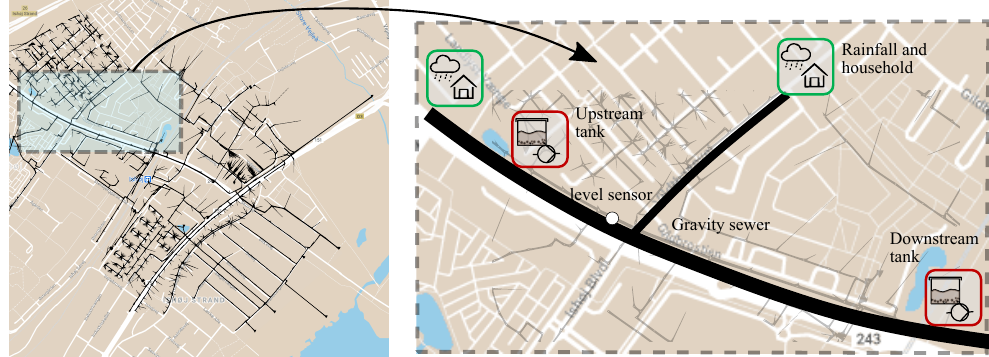
Figure 20. Map of Ishøj and its waste water collection scheme. ( Right ) The complete network model. ( Left ) A section of the sewer with two tanks or open basins and a smaller sewer conveys to the main sewer. Green and red blocks represent the main elements of the network which are emulated with laboratory modules.